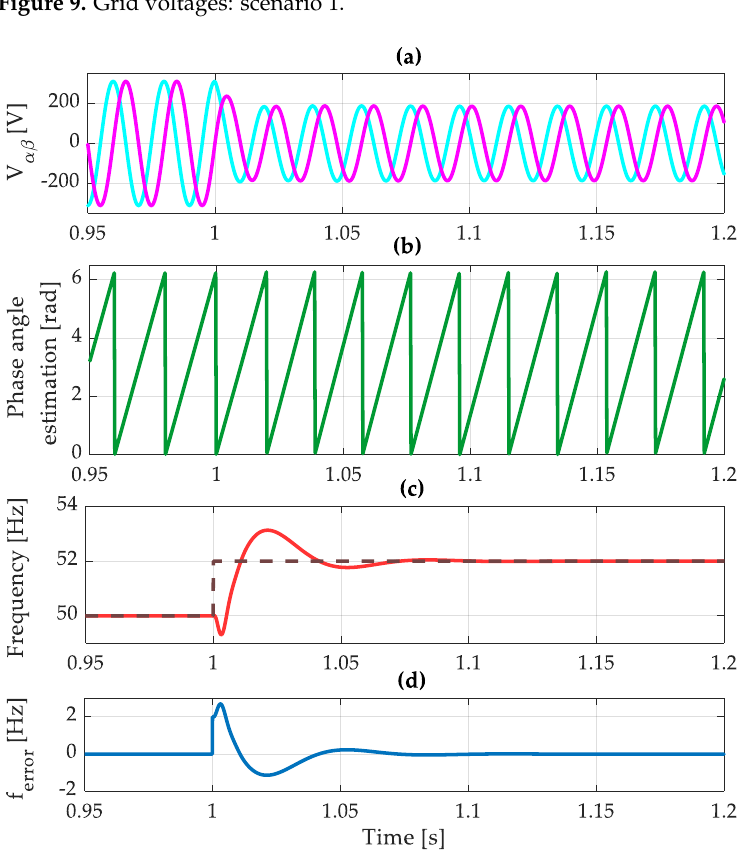
Figure 10. DSOGI-PLL performance for scenario 1: αβ voltages ( a ), phase angle ( b ), frequency ( c ), and frequency error ( d ).